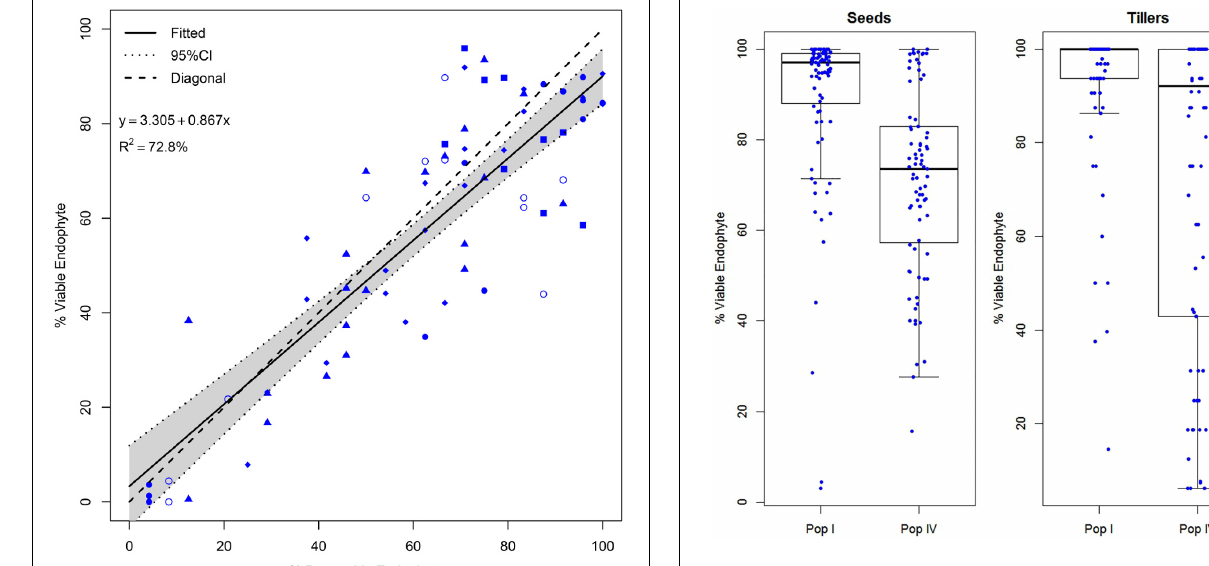
FIGURE 7 | Boxplots showing the distributions of % viable endophyte transmission into seedlings in 2013 (left), and tiller infection levels of parent plants in 2016 (right) in Populations I and IV. Parent plants were grown at the Grasslands Research